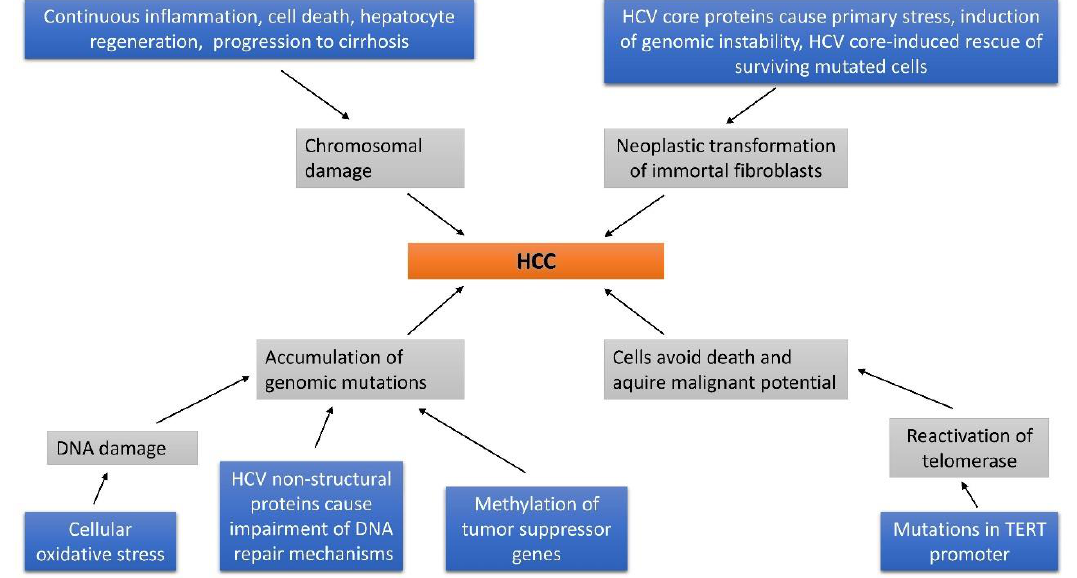
Figure 1. Development of hepatocellular carcinoma in hepatitis C virus (HCV) -infected individuals. The WHO pronounced that 71 million people worldwide suffer from chronic HCV infection. A